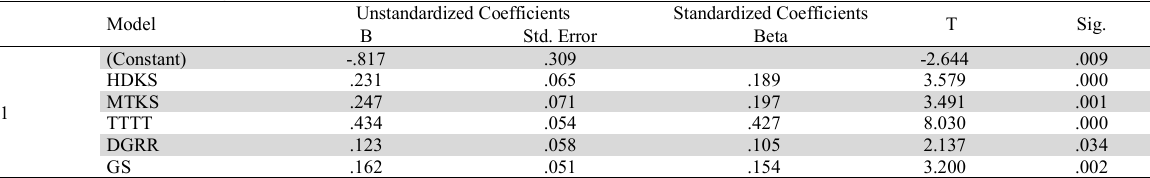
The results of the regression analysis